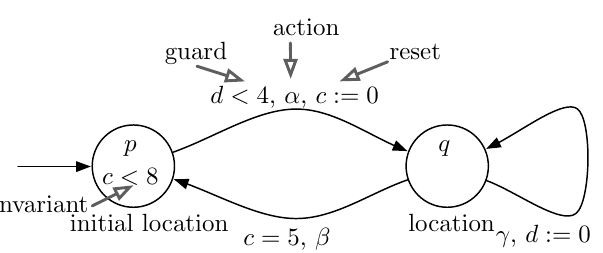
Figure 2: The transition between the location p and q with the label α may take place whenever the clock d < 4 and must take place before the clock c ≥ 8. Once this transition occurs, the clock c resets to